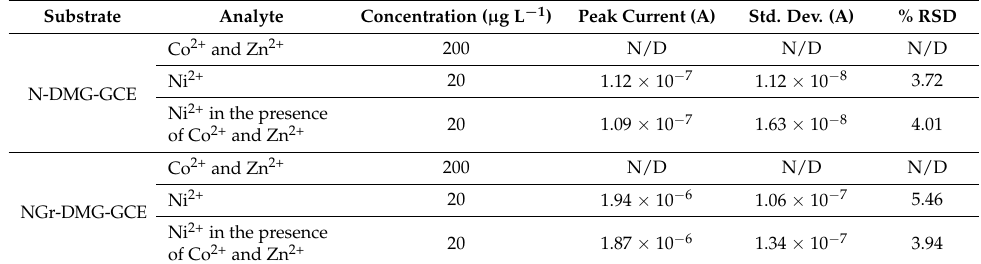
Table 1. Reproducibility and interference studies of the N-DMG-GCE and NGr-DMG-GCE ( n =